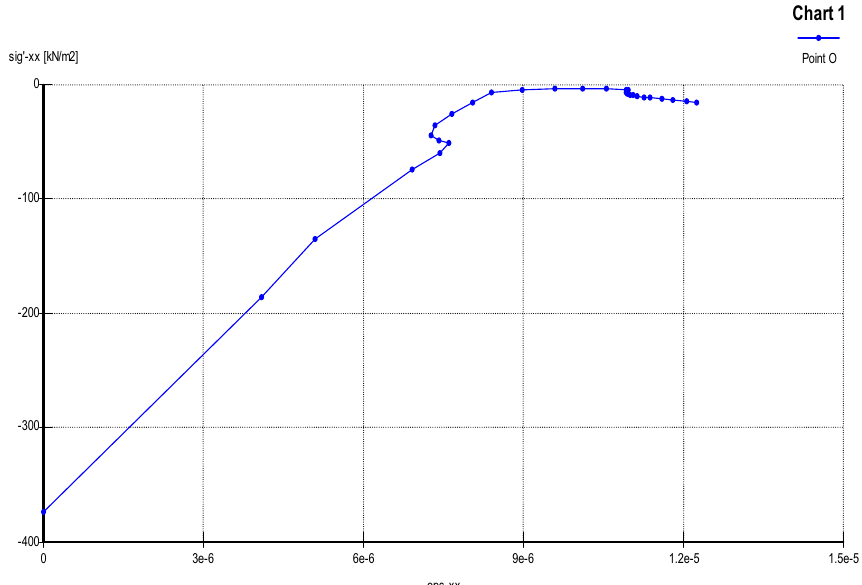
Fig. 11. Vertical Stress- Displacement Curve for Hormheb tomb (KV57), Sig-xx [kN/m 2 ]-eps-xx curve for point